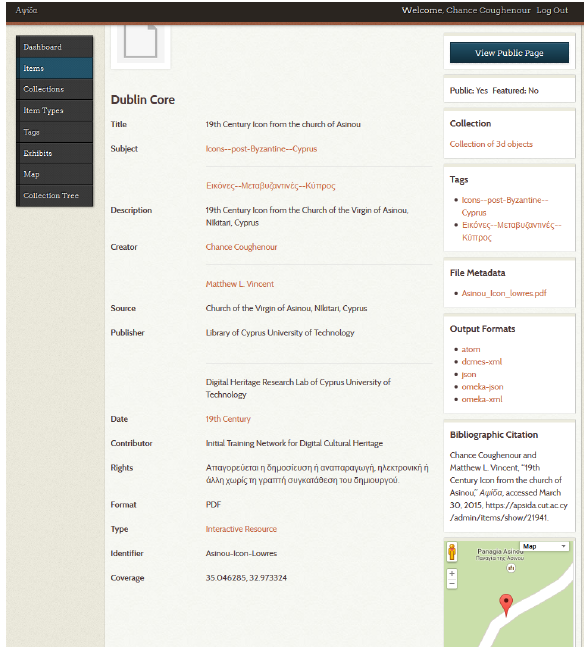
Figure 10: Apsida Metadata